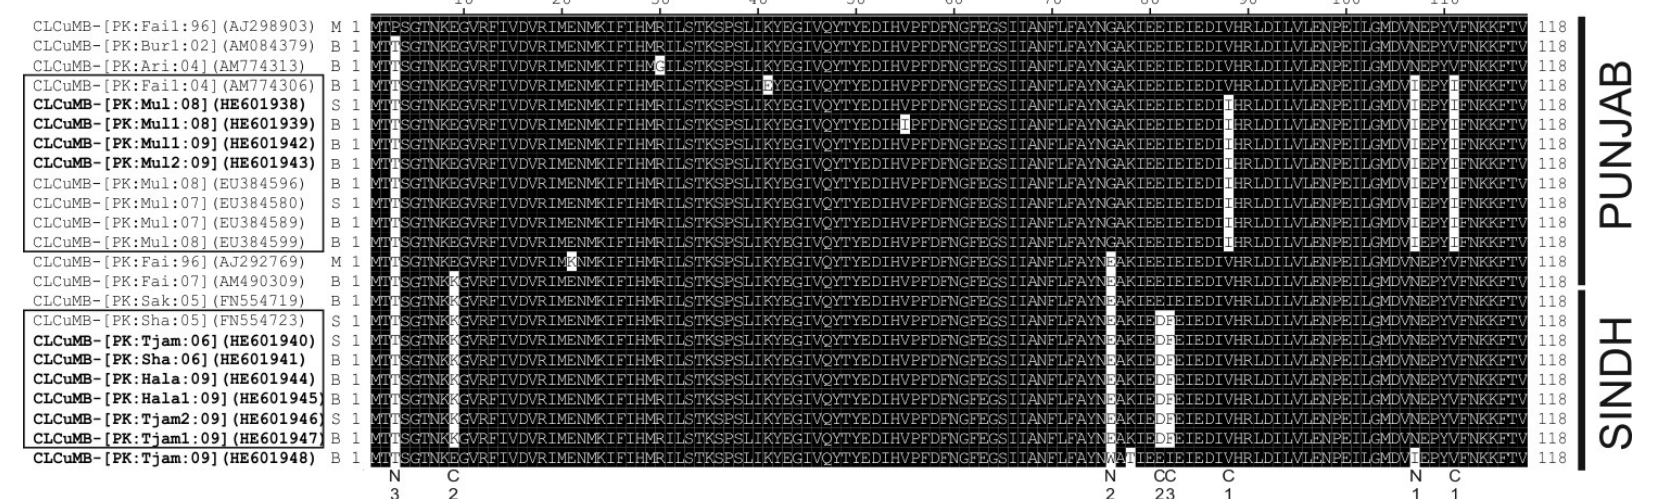
Figure 5. Alignment of the predicted amino acid sequences of the βC1 proteins of selected CLCuMBs. Sequences with the same, or similar, sequence changes have been grouped. In each case, the isolate descriptor, accession number and type (CLCuMB Bur [B], CLCuMB Mul [M], or CLCuMB Sha [S]) are given. Betasatellites produced as part of the study presented here are marked in bold. Sequences are indicated as originating from either the Punjab or Sindh on the right. Standard IUPAC/IUBMB single letter amino acid codes are used. Along the bottom the major amino acid sequence changes are indicated as either conservative (C) or non-conservative (N) with respect to amino acid properties (C1-I and V non-polar/hydrophobic; C2-D,K and E polar/hydrophilic; F and I-non-polar/hydrophobic; N1-I non-polar/hydrophobic whereas N is polar/hydrophilic; N2-G and W non-polar/hydrophobic whereas E is polar/hydrophilic; N3-T polar/hydrophilic whereas P is